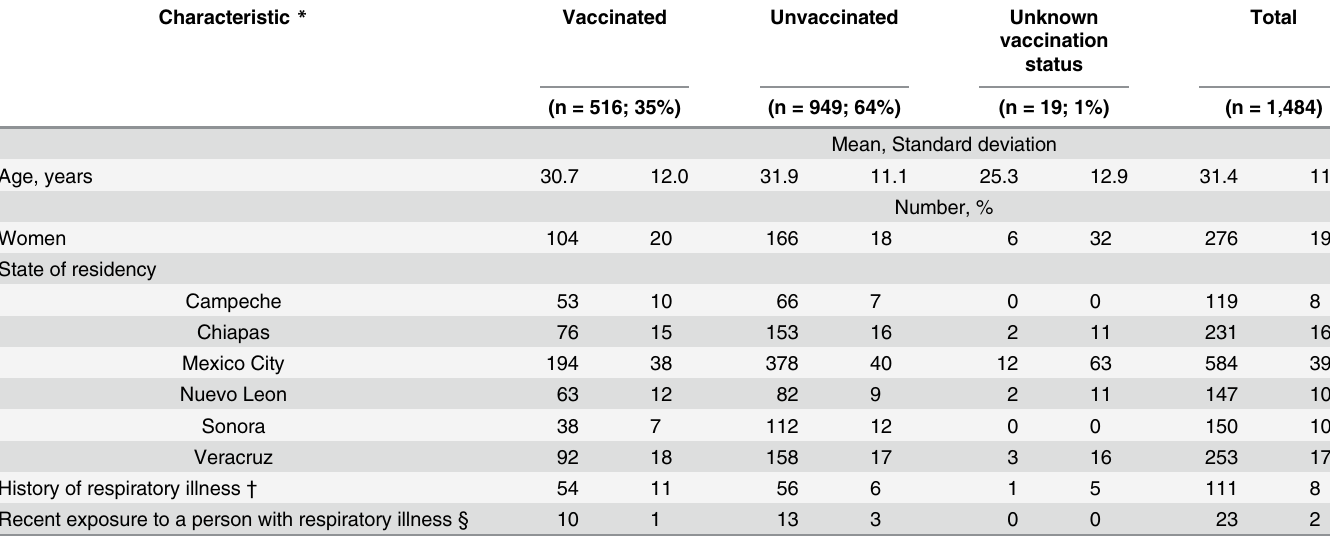
Table 1. Characteristics of 1,484 participants of the influenza A(H1N1)pdm09 serosurvey in blood donors; Mexico, June – September 2010. Characteristic